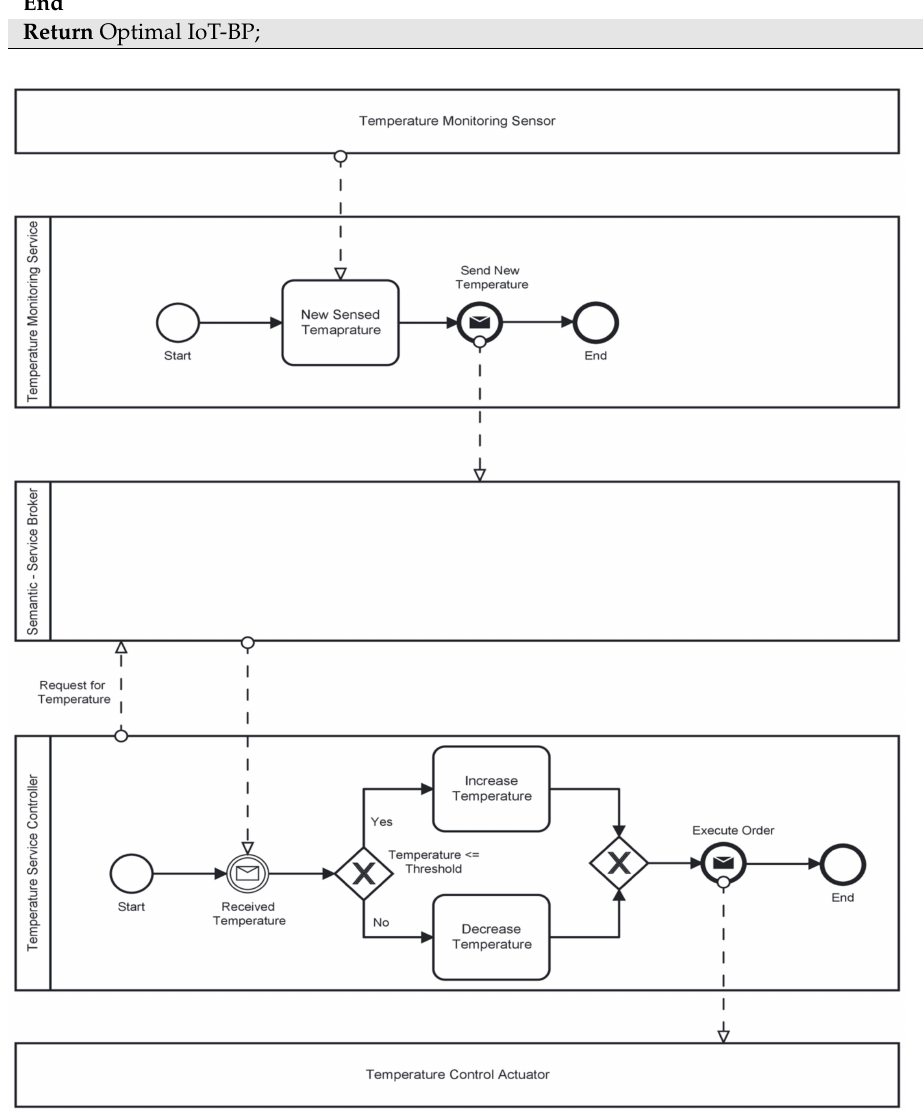
Figure 11. Dynamic semantic-based multi-agent flowchart for services